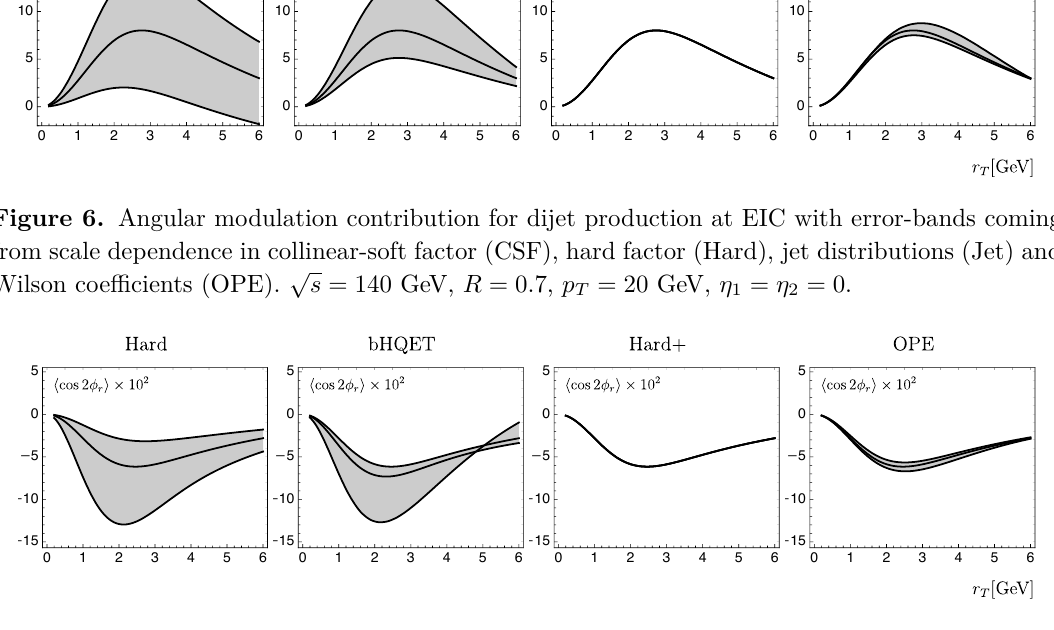
√ s = 140 GeV, p T = 20